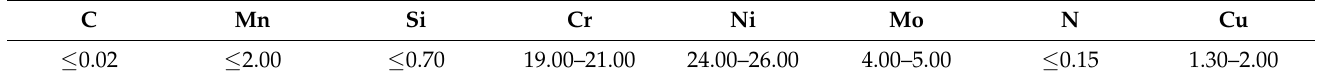
Table 1. Nominal chemical composition of AISI 904L steel (wt. %) (Fe to